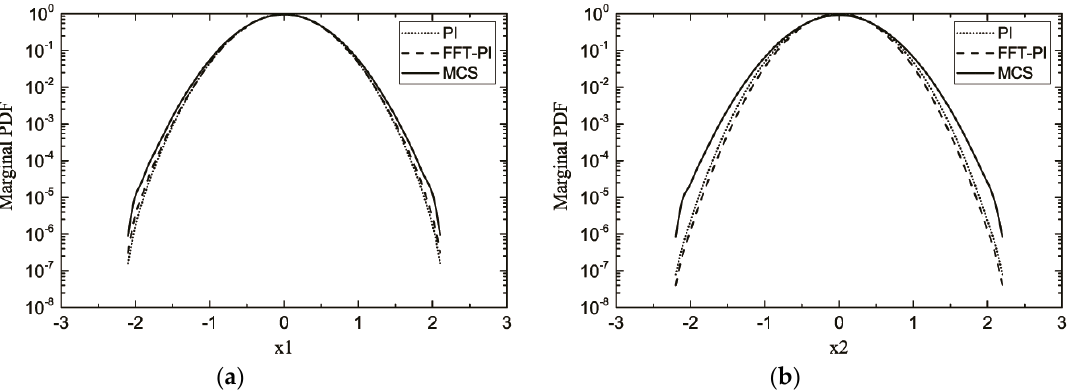
Figure 10. Marginal PDFs of (displacement, velocity): ( a ) PDFs of displacement; ( b ) PDFs of velocity.